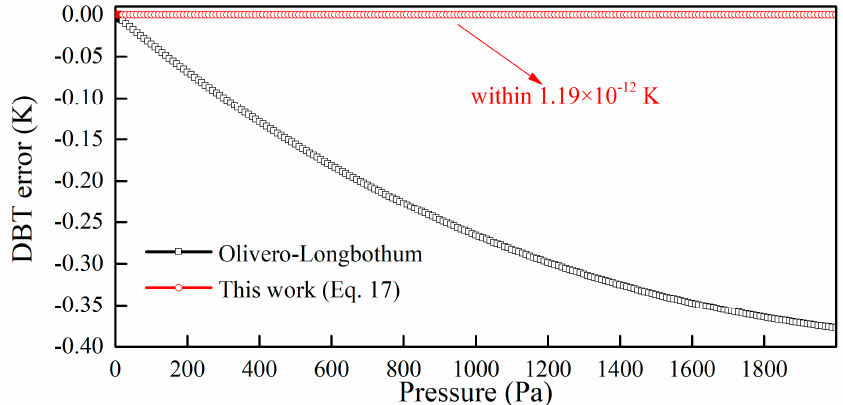
Figure 4. The absolute deviations of DBT temperature calculations using different half-width ap- proximations.